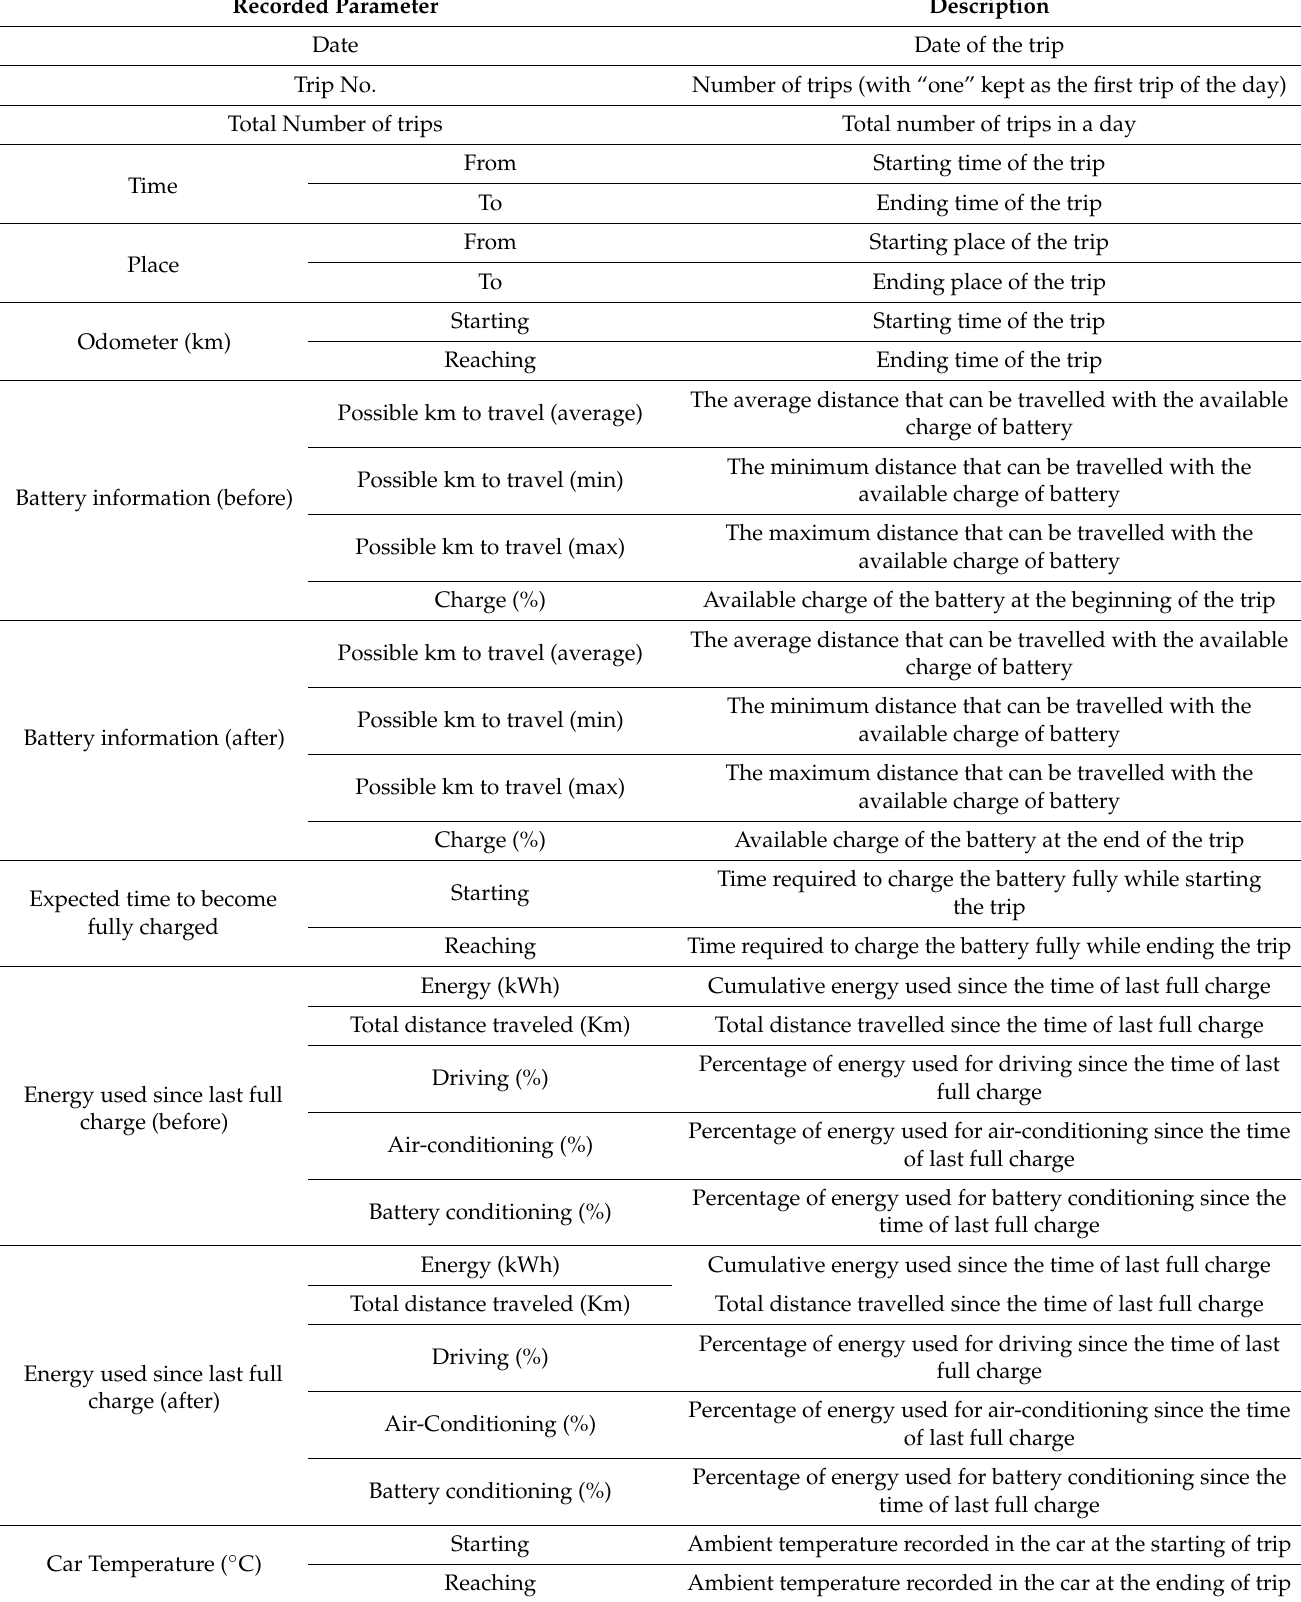
Table 2. Data collection from